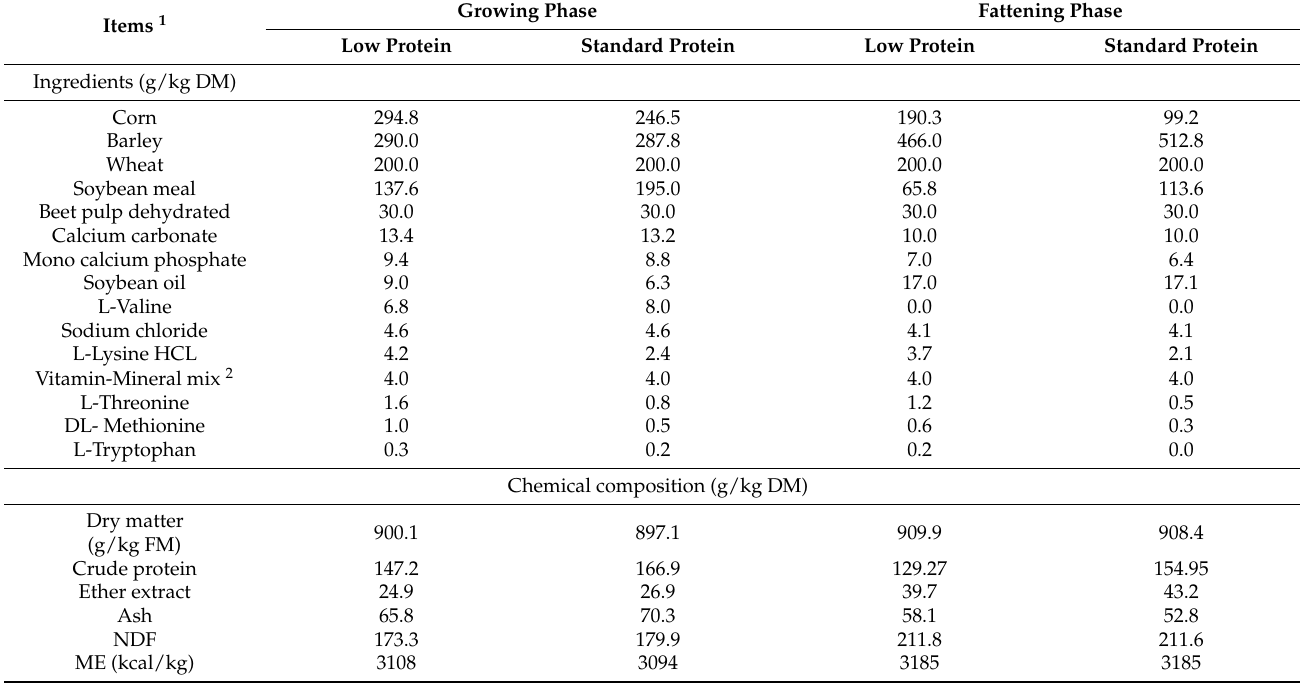
Table 1. Ingredients and chemical composition of the two-phase experimental